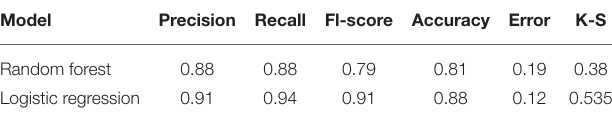
TABLE 1 | The diagnostic accuracy of the lasso and random forest models.